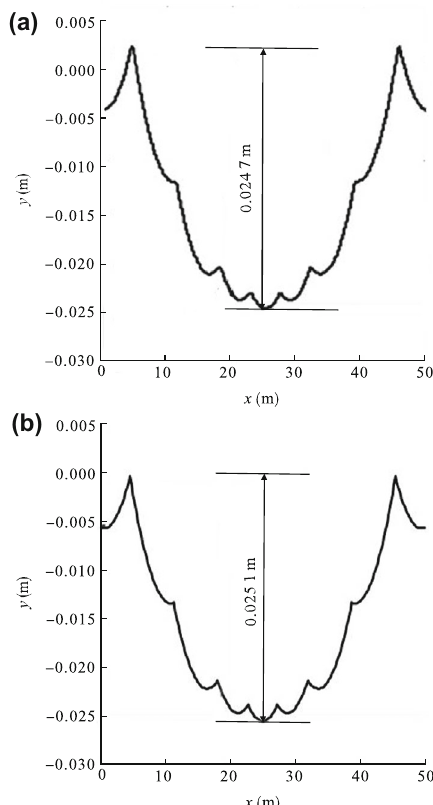
Fig. 4 Contact wire sag: a Lee method; b